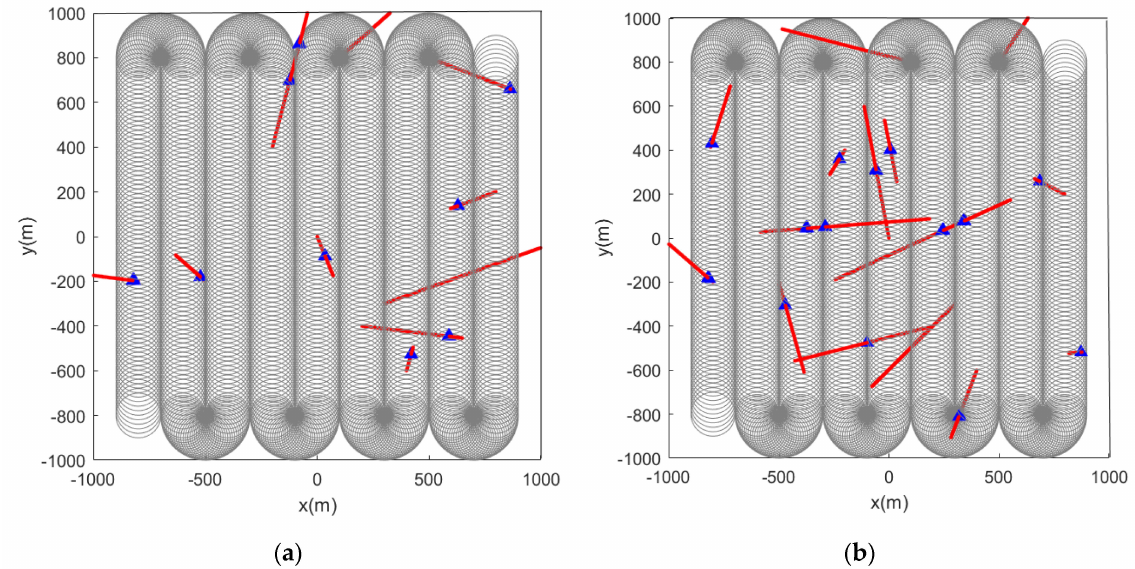
Figure 9. Estimated position of dynamic feature points using the GLMB algorithm (the red track is the feature point motion track; the blue marks indicate the estimated positions of the feature points in the scene). ( a ) Sensor detection radius is 100 m, there are 10 feature points in the scene, and the red track is the feature point motion track; ( b ) sensor detection radius is 100 m, there are 15 feature points in the scene, and the red track is the feature point motion